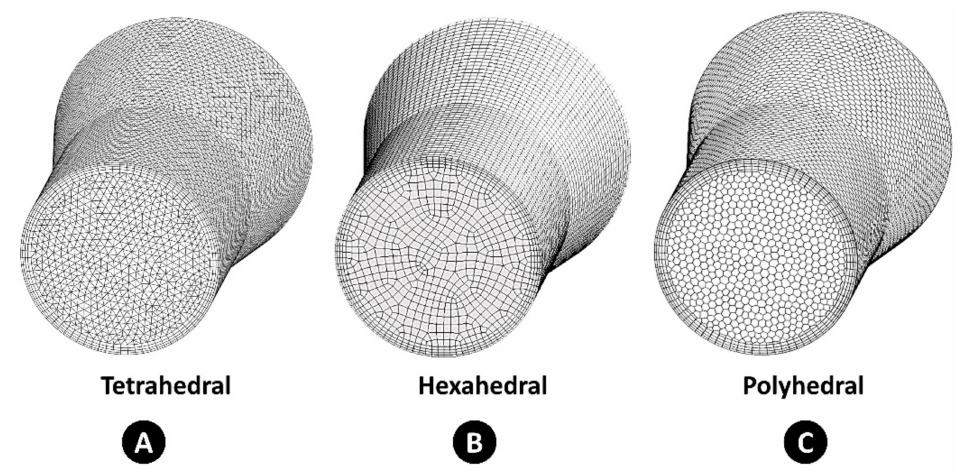
Figure 3. Different mesh cell type for off-gas system inlet region.